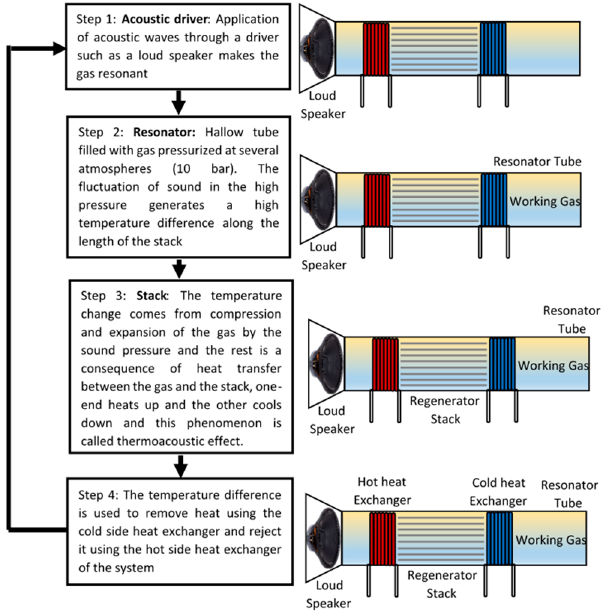
Figure 4. Schematics showing the basic working principle of Thermoacoustic Refrigeration.